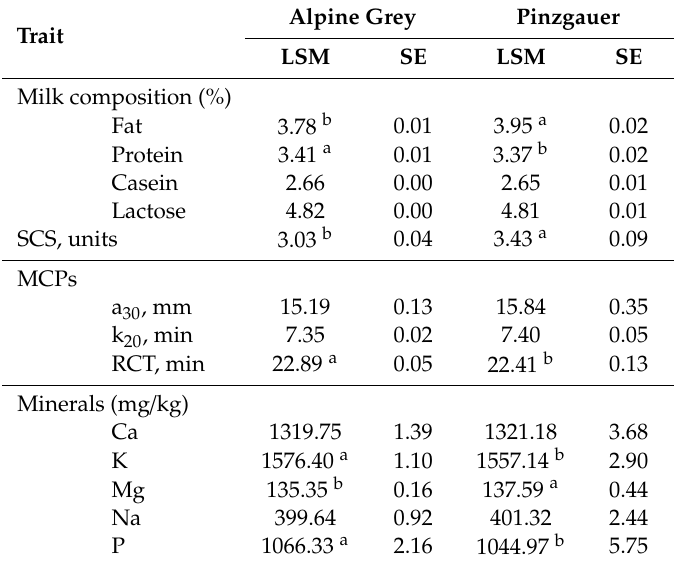
Table 4. Least squares means of bulk milk traits for the fixed e ff ect of breed. Alpine Trait